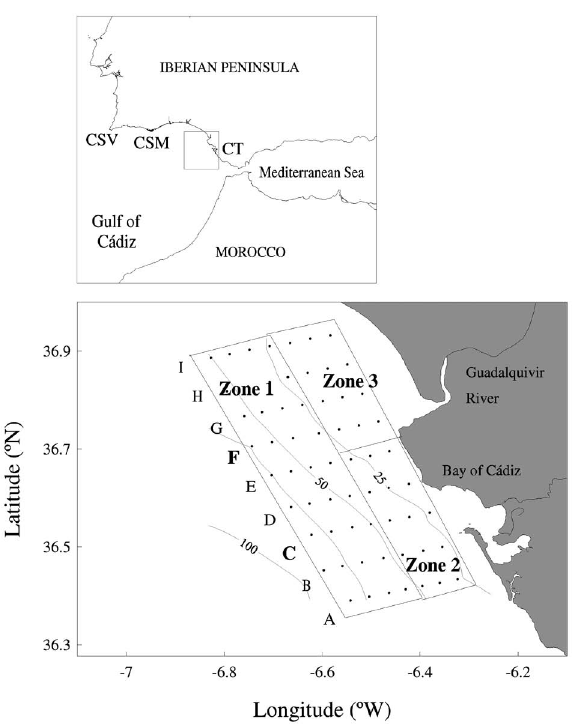
f ig . 1. – Map of the northeastern continental shelf of the Gulf of Cádiz (SW Iberian Peninsula). Solid points indicate sampling sta- tions for the EMIGAS I (summer), II (autumn), III (winter) and IV (spring) cruises. Letters from ‘A’ to ‘I’ correspond to transect labels. The three zones into which the study area is divided are also shown: zone 1, corresponding to the oceanic area, zone 2, corresponding to the southern area, and zone 3, corresponding to the northern area. CSV, CSM and CT stand for Cape San Vicente, Cape Santa Maria and Cape Trafalgar respectively. Isobaths are in